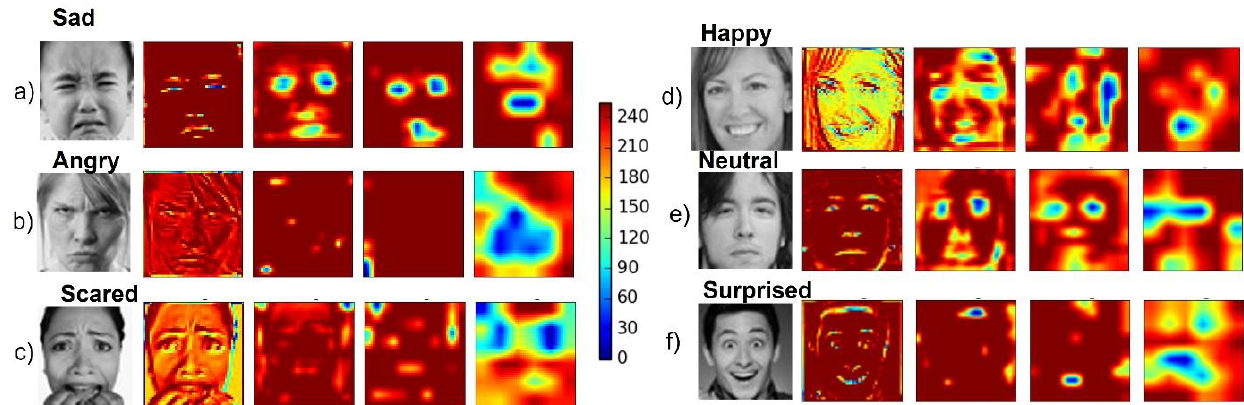
Figure 6. Convolutional neural network (CNN) heatmaps. Representative input image of the FER2013 dataset along with the related heatmap resulting from each of the four convolutional layers for images labeled ( a ) sad, ( b ) angry, ( c ) scared, ( d ) happy, ( e ) neutral, and ( f ) surprised.